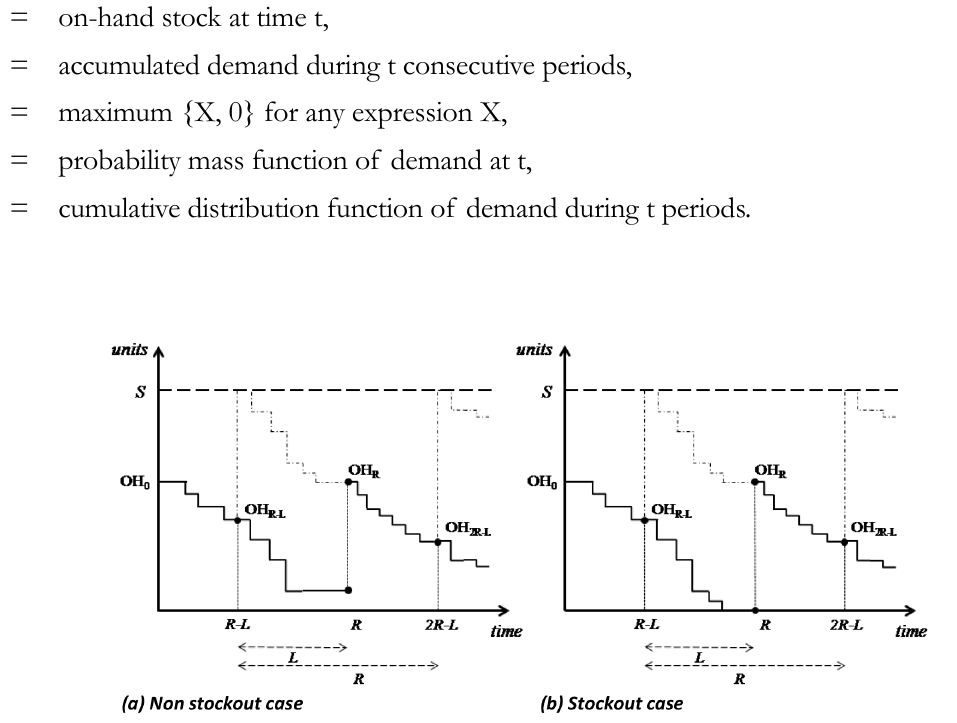
Figure 1. Periodic review system with lost sales with and without